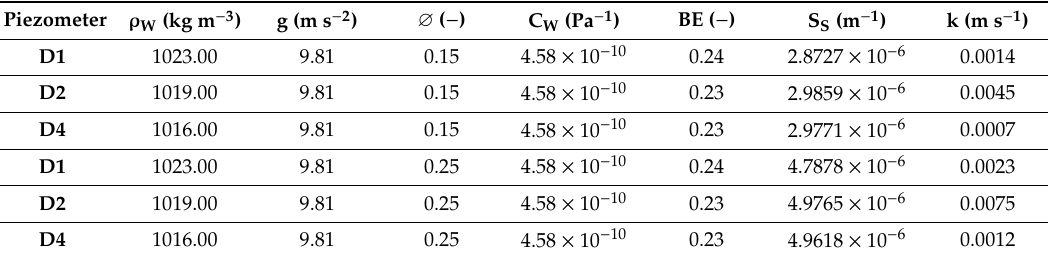
Table 3. Hydrogeological parameter